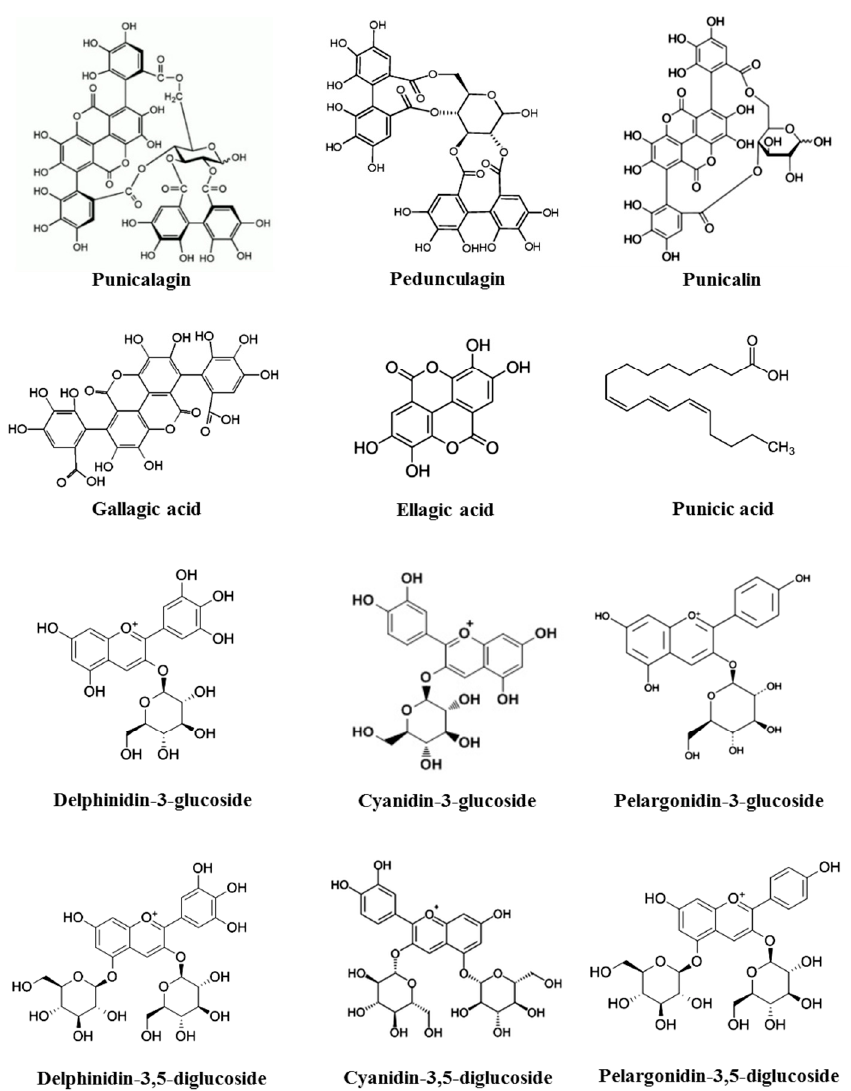
Figure 1. Chemical structures of major constituents present in pomegranate.